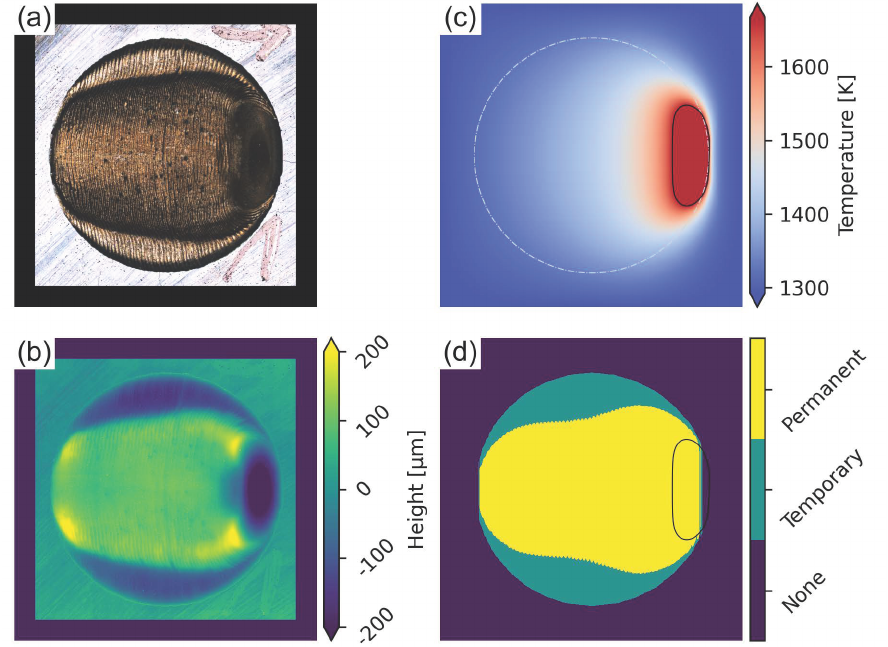
Figure 4. ( a ) Surface of a remelted single layer circle on CMSX-4 at 1000 ◦ C with a lateral melt direction from left to right. ( b ) corresponding surface topography according to laser scanning microscopy. ( c ) predicted temperature field of the circle geometry (light grey) and final melt pool (black) according to numerical simulation. ( d ) calculated persistent regions (temporary persistent regions are filled for better visibility) and final melt pool